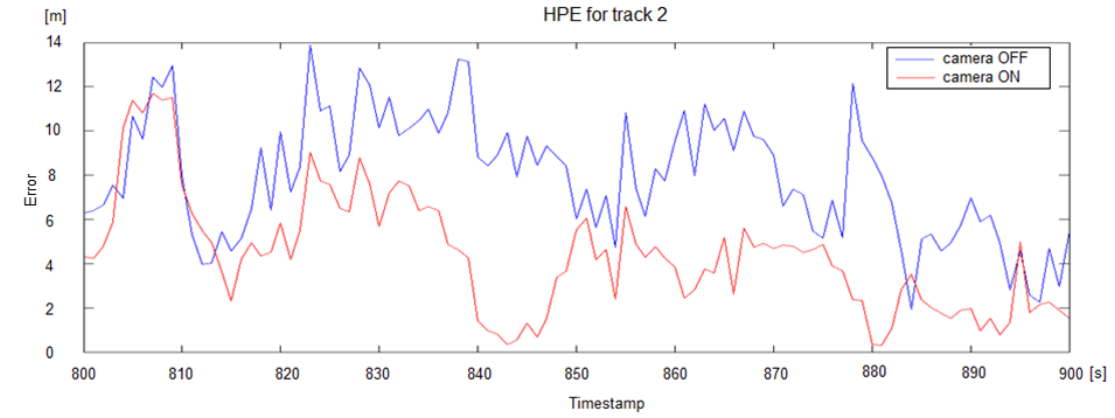
Figure 7. HPE zoomed around timestamp 850.